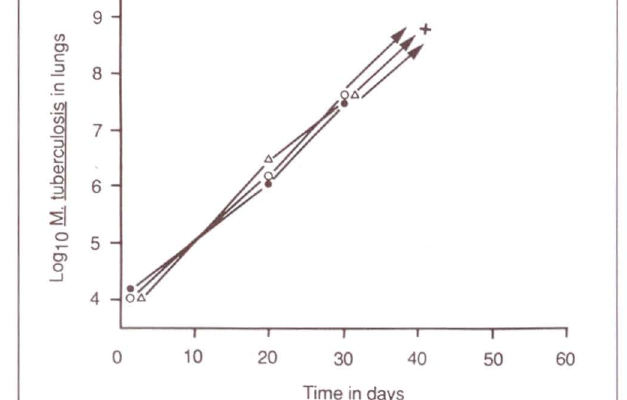
Figure 1) Growth of Mycobacterium tuberculosis in the lungs of infected mice. Mice were infected with 10 4 M tuberculosis